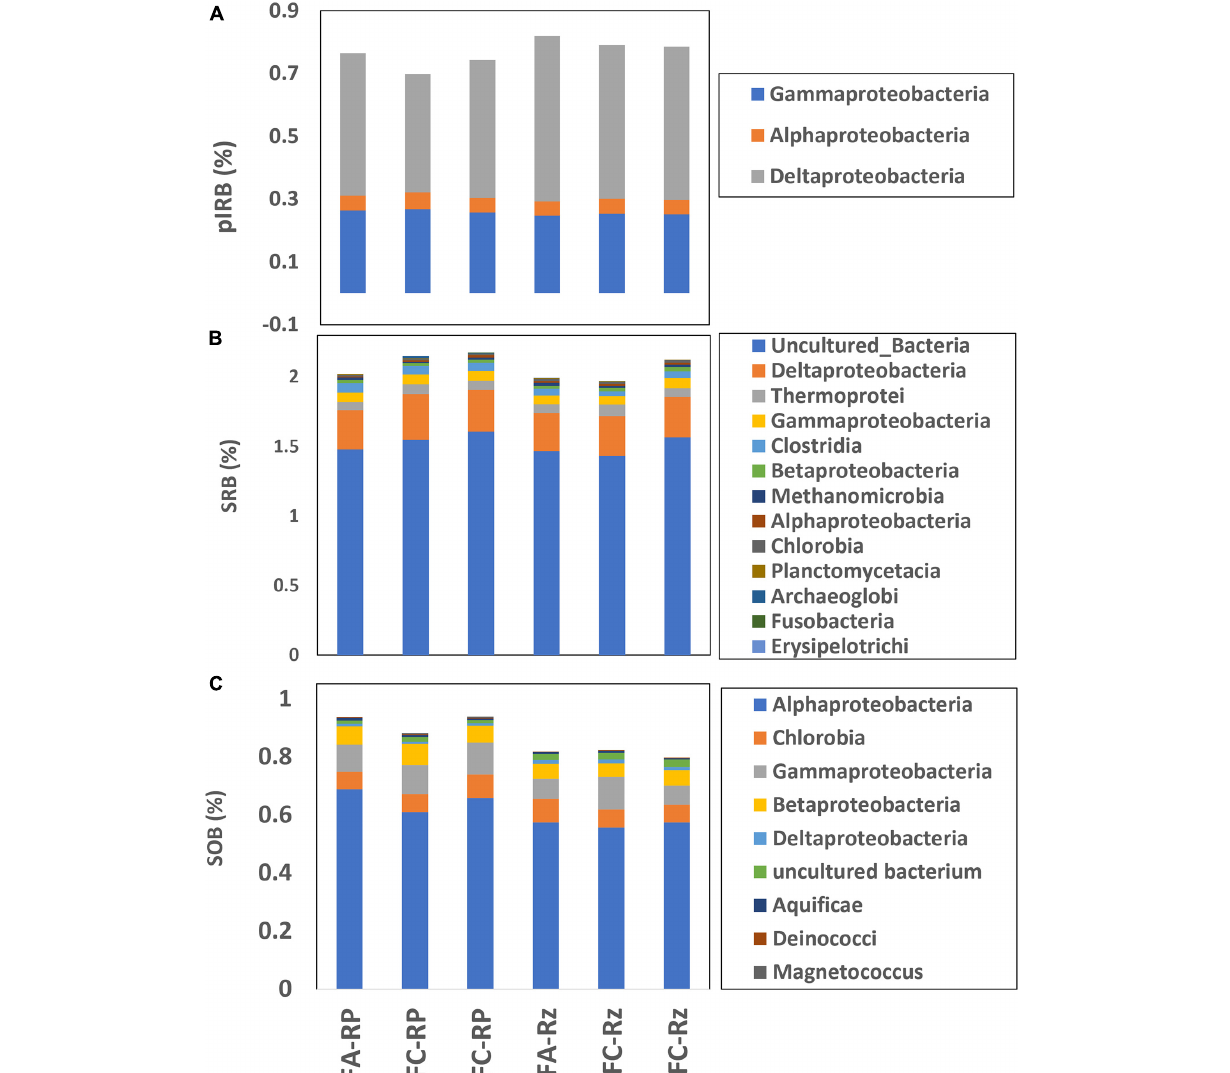
Frontiers in Microbiology |